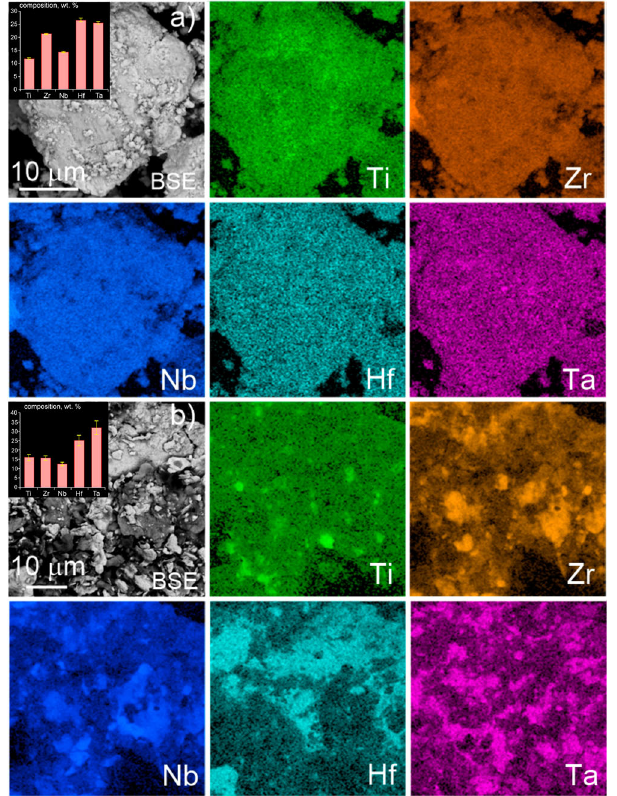
Fig. 5 SEM images of experimental samples with energy dispersive X-ray analysis. a Single- and b multi-phase samples. Dispersive X-ray analysis images show the mapping of chemical elements across the sample. 20 points across the sample were used to measure the elemental distributions (shown in the inset).